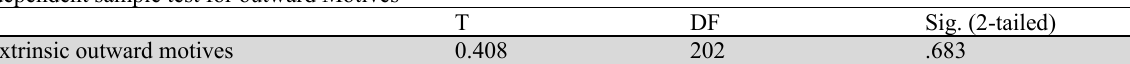
Independent sample test for outward Motives